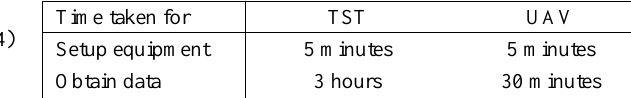
Table 5. Time comparison between both